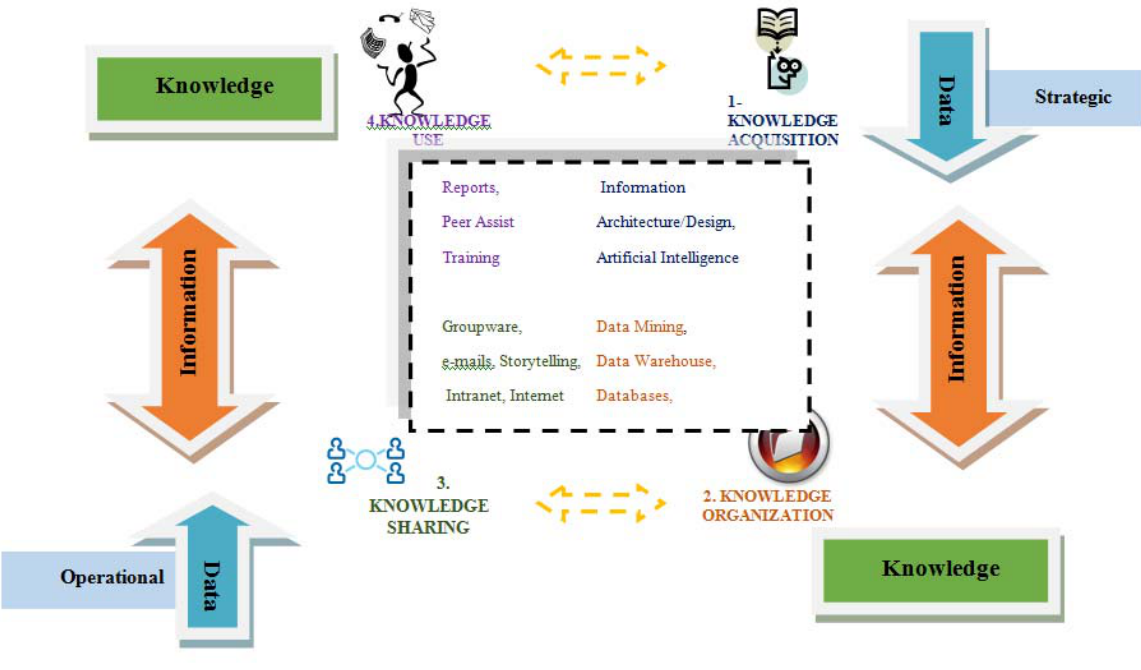
Fig. 1. Cultural perspective on pattern of retrieval, organization, use, and sharing of information and